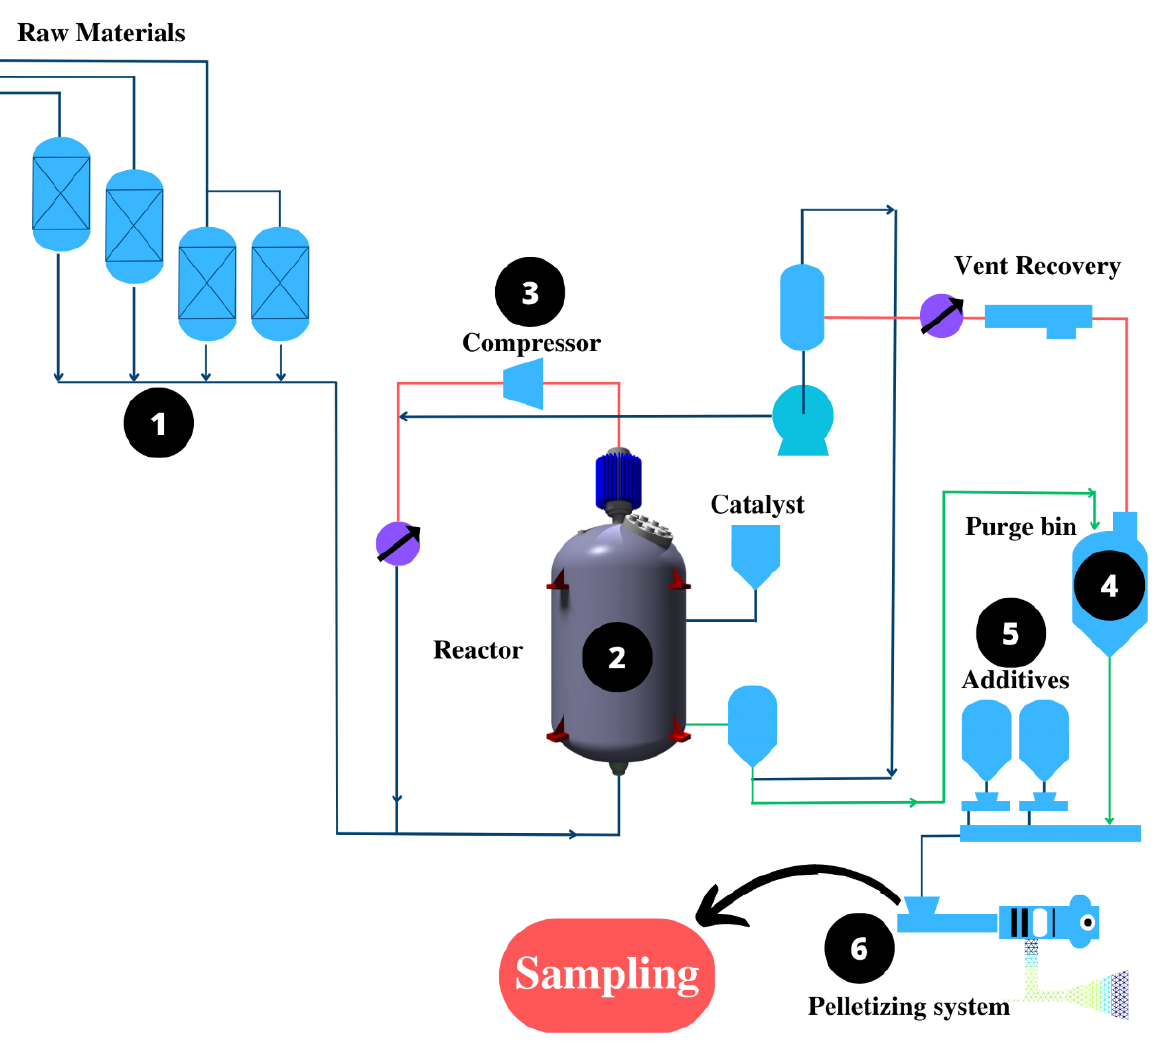
Figure 2. PP production flow diagram.